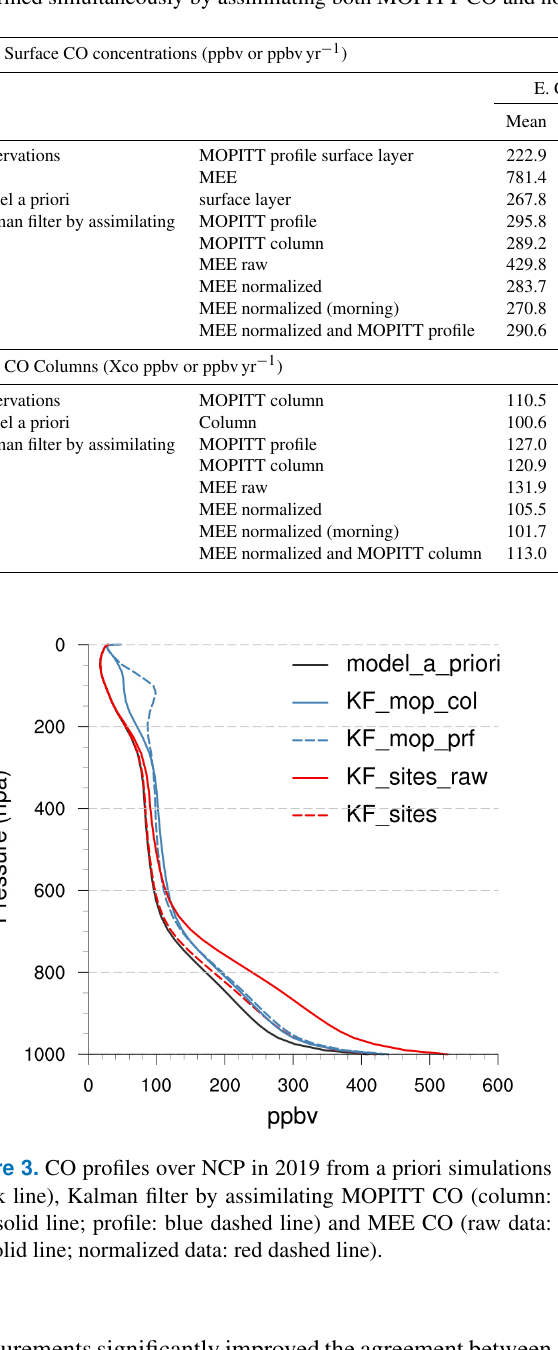
Table 1. Averages and trends of surface (T 1.1) and column (T 1.2) CO concentrations in 2015–2020. The domain definitions are shown in Fig. 1a. The East Asian CO boundary conditions are provided by global a priori simulations, except Kalman filters, by assimilating MOPITT CO, while the boundary conditions are provided by global assimilations of MOPITT CO. The “MEE normalized and MOPITT column” is performed simultaneously by assimilating both MOPITT CO and normalized surface CO measurements.